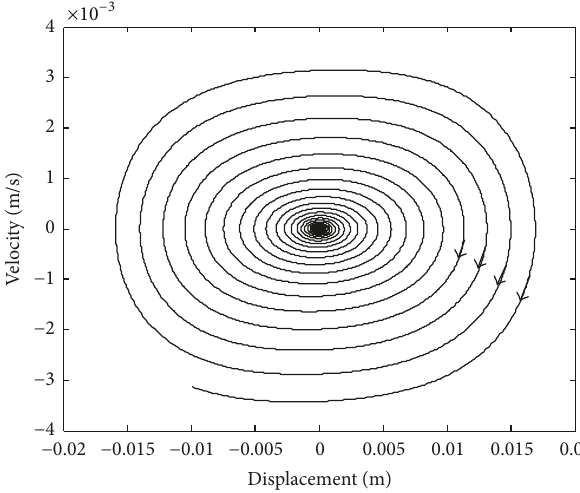
Figure 5: Numerical simulation for region (II), for ( 𝐾 1 , 𝐾 2 ) = (0.02, − 0.01).